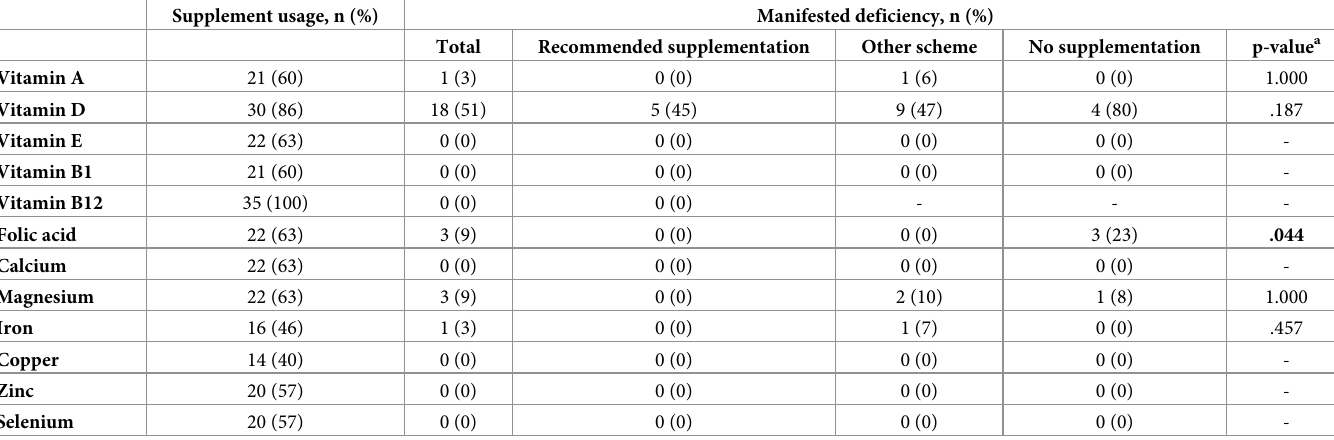
Table 4. Supplement usage and prevalence of manifested deficiency of critical micronutrients in patients after bariatric surgery (n = 35). Supplement usage, n